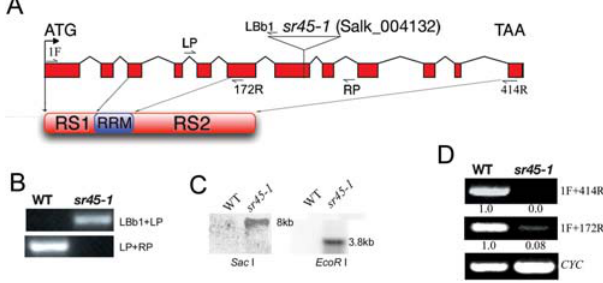
Figure 2. Molecular characterization of sr45-1plants. (A) Gene structure of SR45 (At1g16610). Filled rectangles are exons; thin lines are introns; inverted open triangle indicates the position of the T-DNA insertion in the 7 th exon. The location of various primers used in PCR is indicated by half-head arrows. The schematic diagram below the gene structure shows domain organization of SR45 protein. The correspond- ing gene positions coding for the N-terminal arginine/serine rich (RS1) domain, the middle RNA recognition motif (RRM) and the C-terminal RS2 domain are indicated by downward arrows. (B) Verification of the sr45-1 insertion in the genomic DNA by PCR with SR45 -specific primers (LP and RP) and the T-DNA-specific primer LBb1; the locations of these primers relative to the T-DNA insertion are shown in (A). (C) Southern blot showing single insertion of T-DNA. Genomic DNA from WT and sr45-1 was digested with either SacI or EcoRI and probed with a 32 P- labeled T-DNA probe. (D) RT-PCR expression analyses of SR45 in WT and sr45-1 plants using SR45 -specific primers (1F and 414R, which will amplify full-length SR45 ; 1F and 172R will amplify a truncated SR45 transcript before the T-DNA insertion). Cyc, cyclophilin product was amplified to show equal amount of cDNA template in PCR. PCR product in WT and sr45-1 was normalized to cyclophilin expression in WT and sr45-1 , respectively. Numbers below each panel indicate the level of transcript in WT and sr45-1 plants. The level of SR45 transcript in WT is considered as 1.